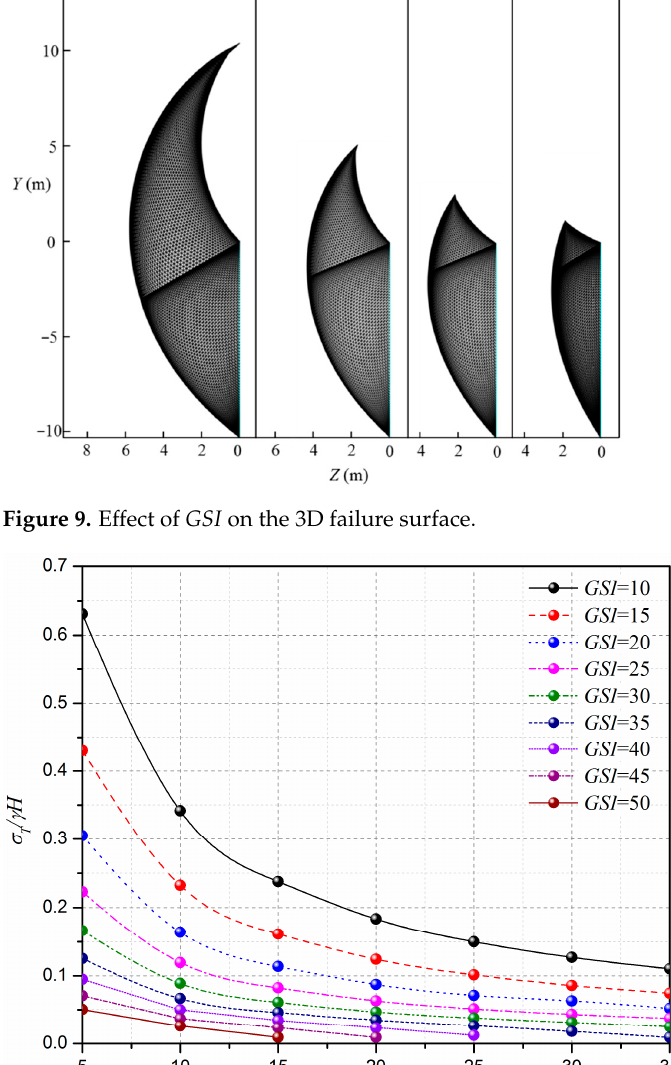
Figure 10. Effect of m i on the normalized limit support pressure σ T / γ H